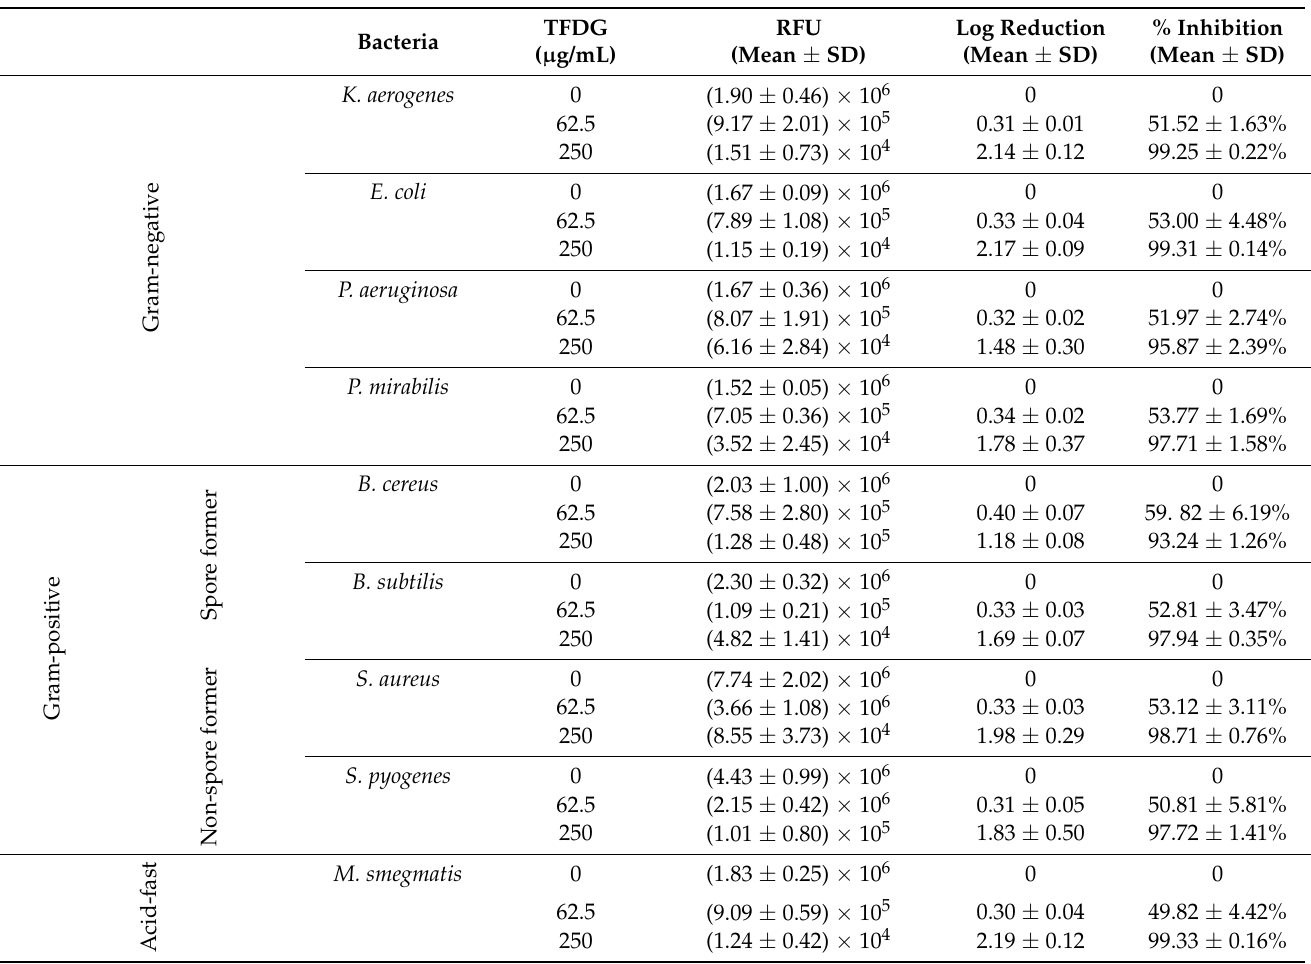
Table 2. Relative fluorescence unit (RFU) with the log reduction and percent inhibition of different bacteria treated with TFDG based on BacTiter-Glo TM